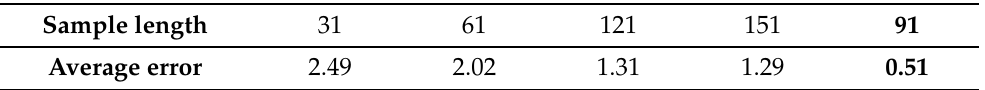
Table 5. Heart rate estimation error under different sample lengths. The bold are the sample length set in our method and the heart rate estimation error.